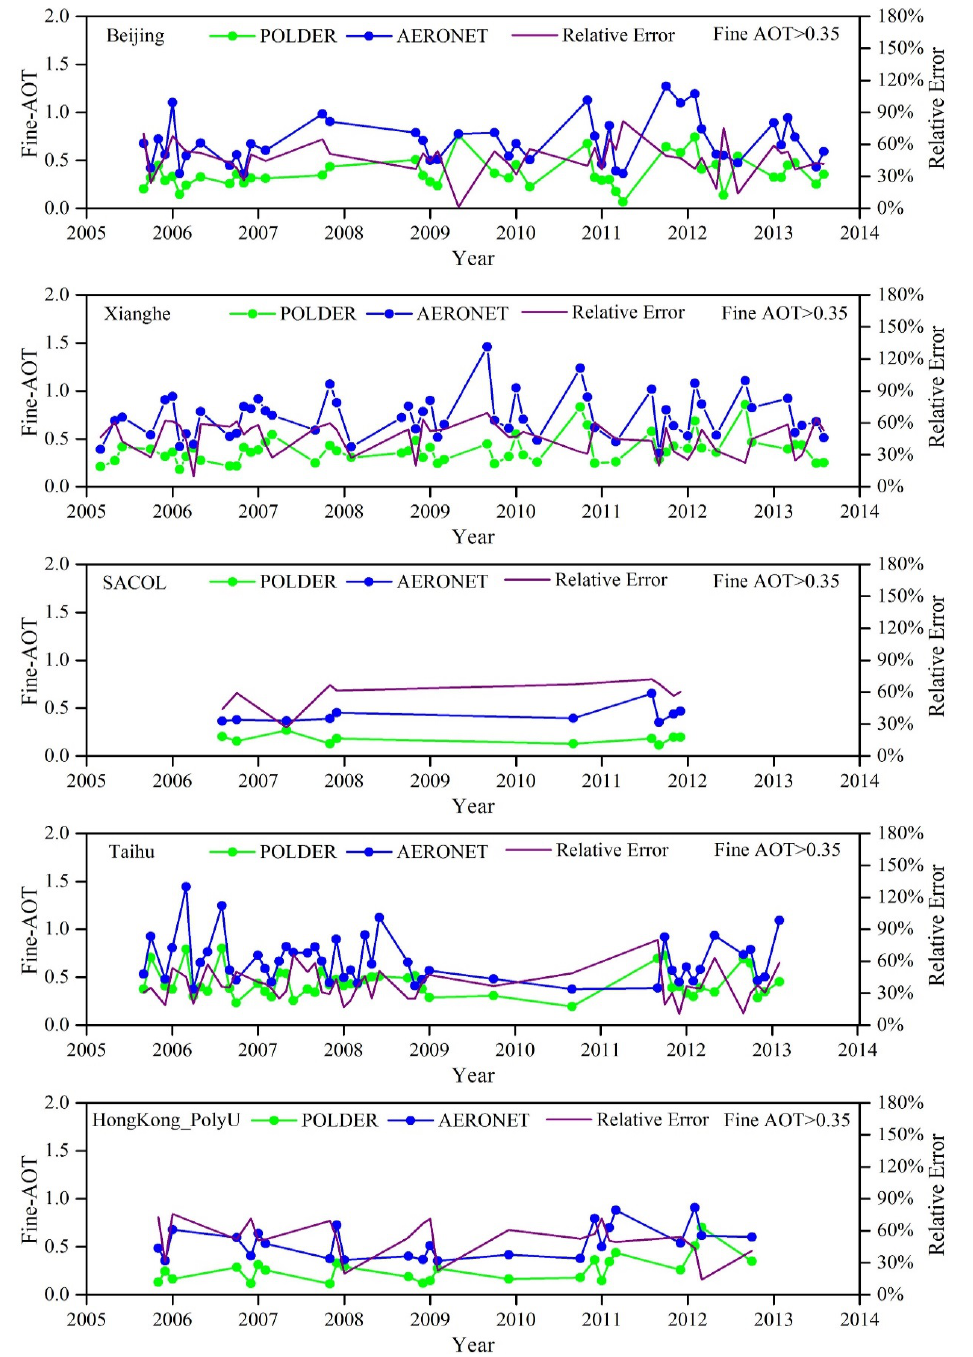
Figure 3. Monthly averages of POLDER and AERONET fine AOTs at 550 nm and their relative errors at five AERONET sites for daily mean fine AOTs larger than 0.35 from 2005 to